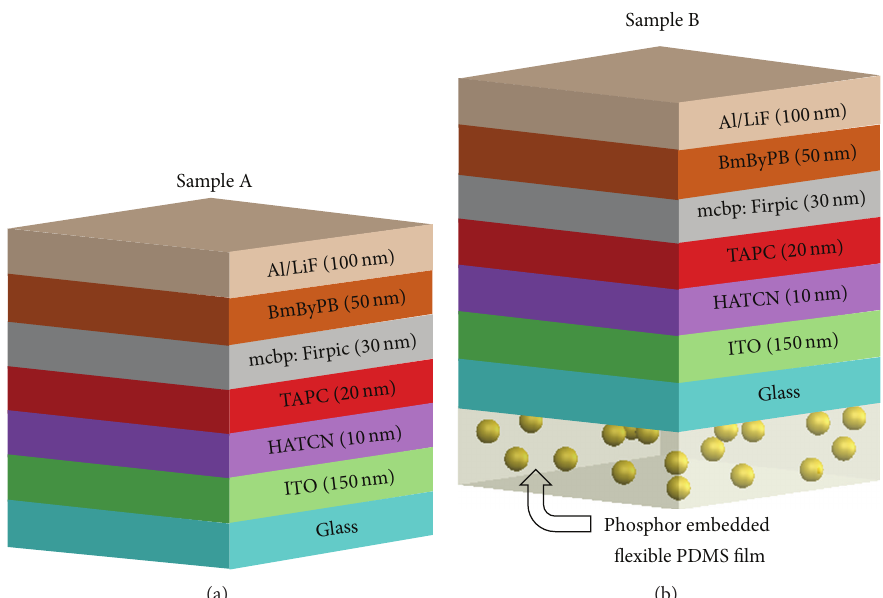
Figure 1: Schematic structures of OLEDs device (a) without a yellow phosphor embedded flexible film as a reference and (b) with a yellow phosphor embedded flexible